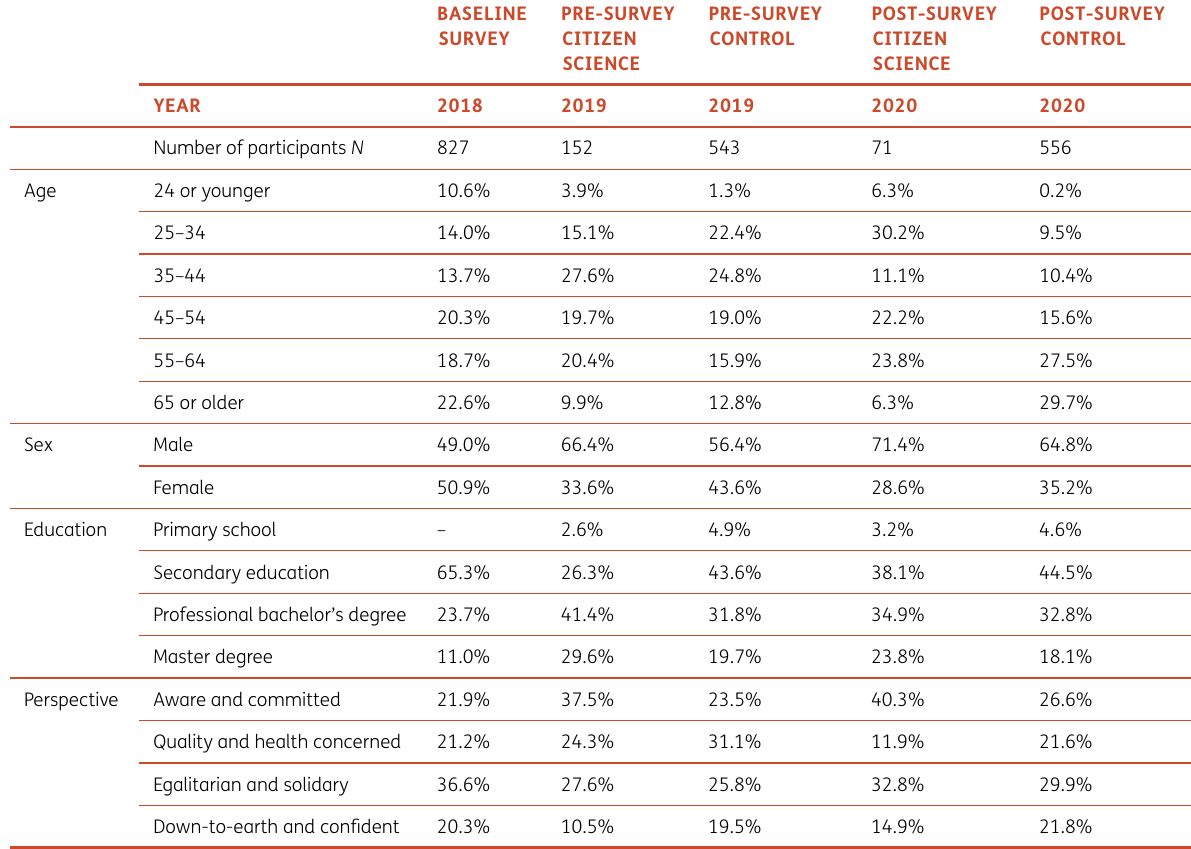
Table 2 Study sample